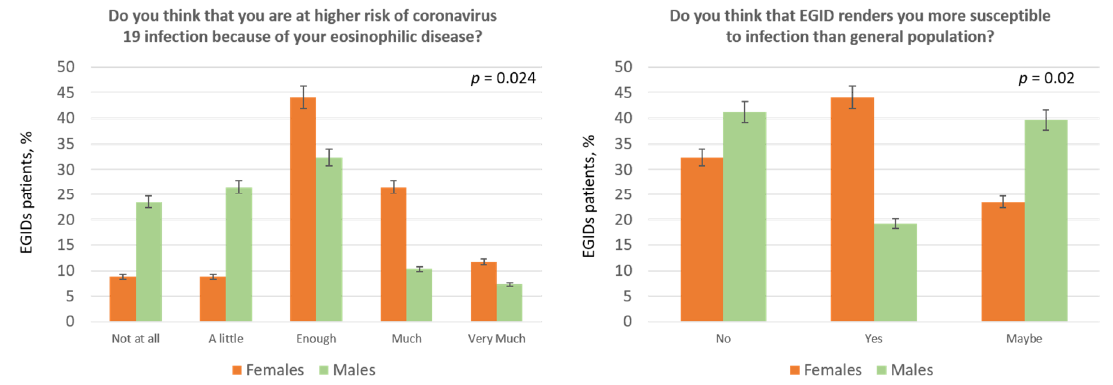
Figure 3. Perception of COVID-19 infection based on gender.